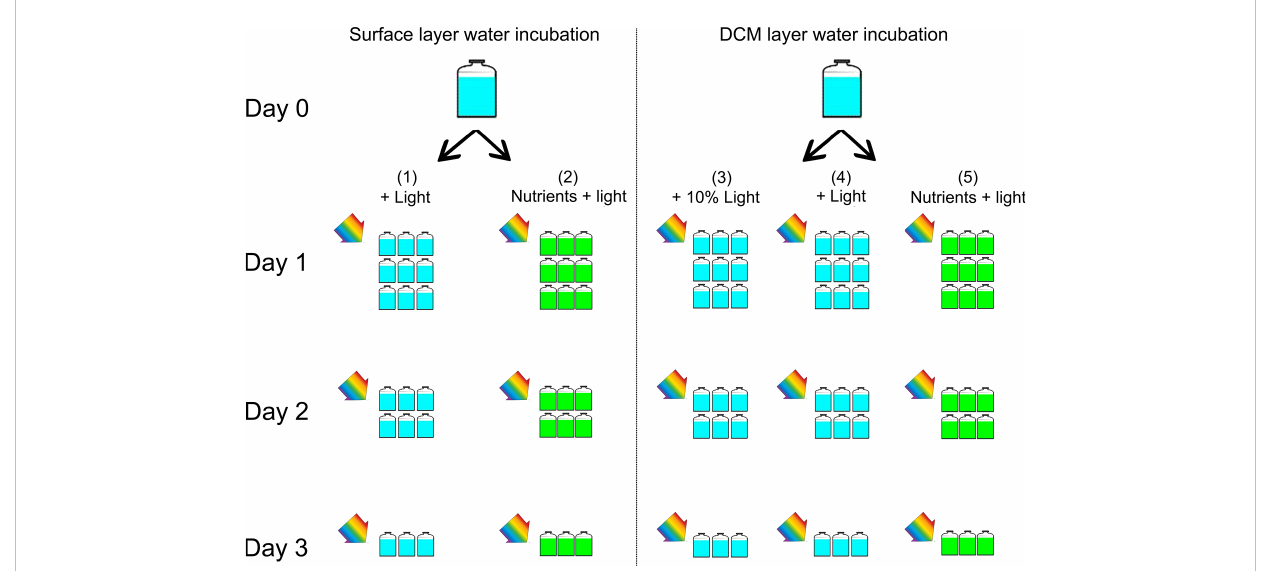
FIGURE 3 Experimental setup. The water samples of the surface layer (1 m) and the DCM layer (50 m) at station B6 were pre- fi ltered through 200 m m nylon mesh. For surface water, (1) Control: water sample + light; (2) water sample + nutrients + light. For the DCM layer water, (3) Control: water sample + 10% light; (4) DCM layer water + light; (5) DCM layer water + nutrients + light. In the group (3), the tank was covered with several layer of neutral density screens in order to reduce the ambient light by 90%, simulating the weak light of DCM layer. All bottles were placed in a water tank with surface seawater fl owing to ensure that the incubation temperature was consistent with the surface water temperature of the ocean with a light- dark cycle of 12 h: 12 h. Incubation started at 7:00 in the morning, and ended at 3 days later. The samples during the incubation were taken at T=0, 24, 48, and 72 hours. During each sampling time, we consume three bottles (replicates) of each group for analysis of nutrients, counts of cell abundance, analysis of DNA for microbial community, and continue to incubate the rest bottles until the